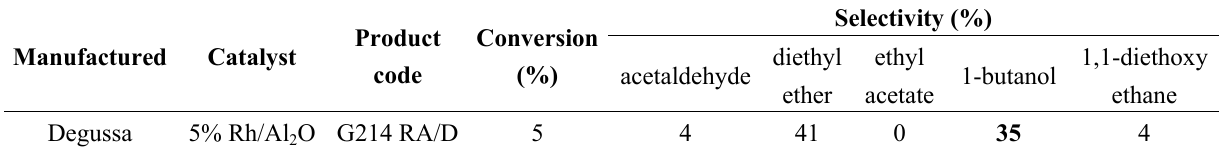
Table 4. Results obtained with alumina supported Rh catalyst.